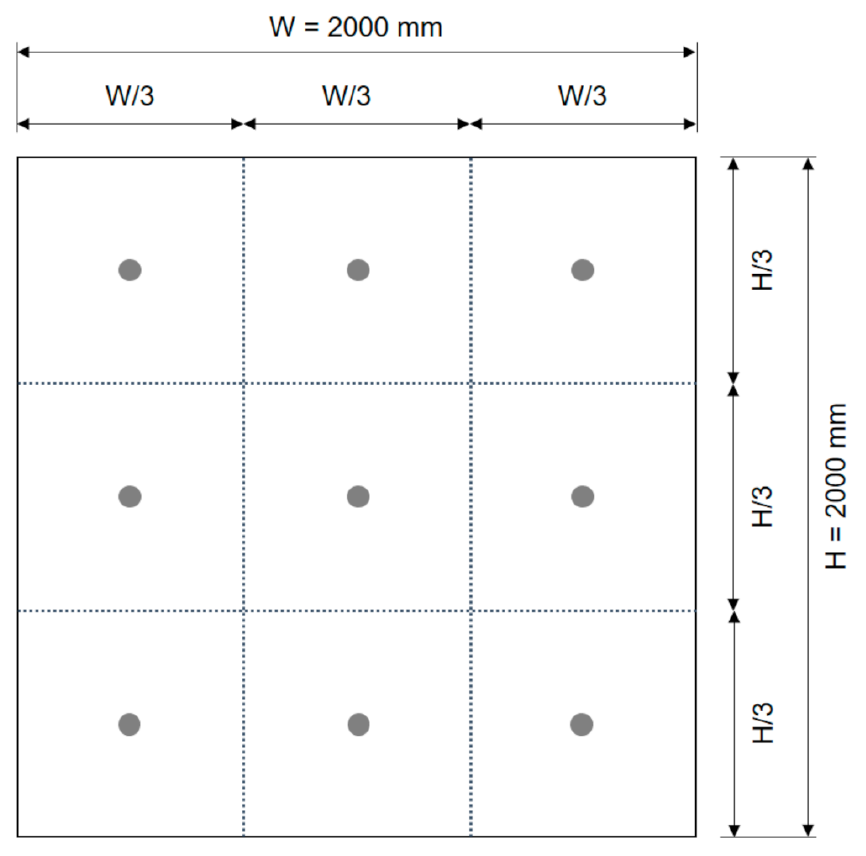
Figure 14. Surface temperature measurement points on the cold box and hot box side to pre-set the surface thermal